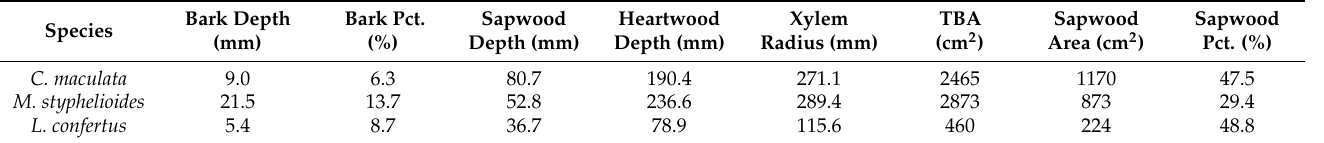
Table 2. Wood properties of the C. maculata , M. styphelioides and L. confertus used in these experiments.